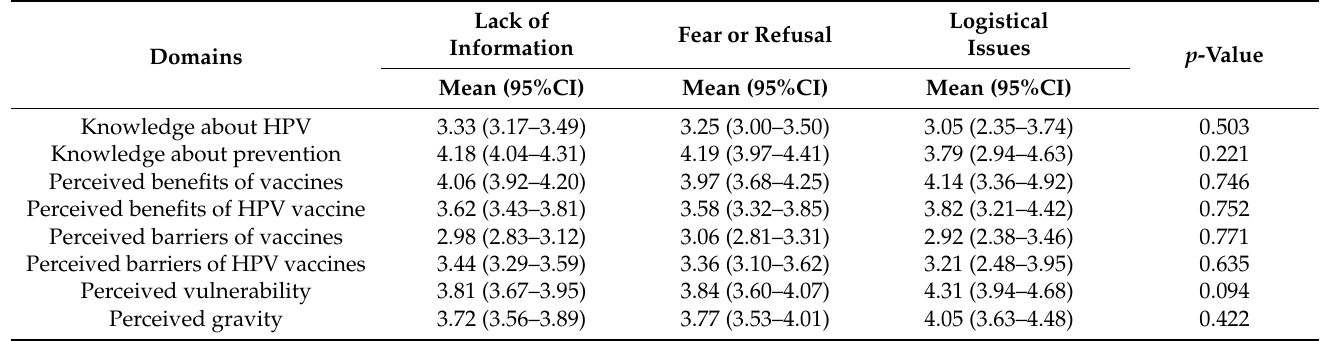
Table 4. Main reasons for non-vaccination according to knowledge scores about the Human Papillo- mavirus (HPV) and about prevention and domains of the health belief model (n =